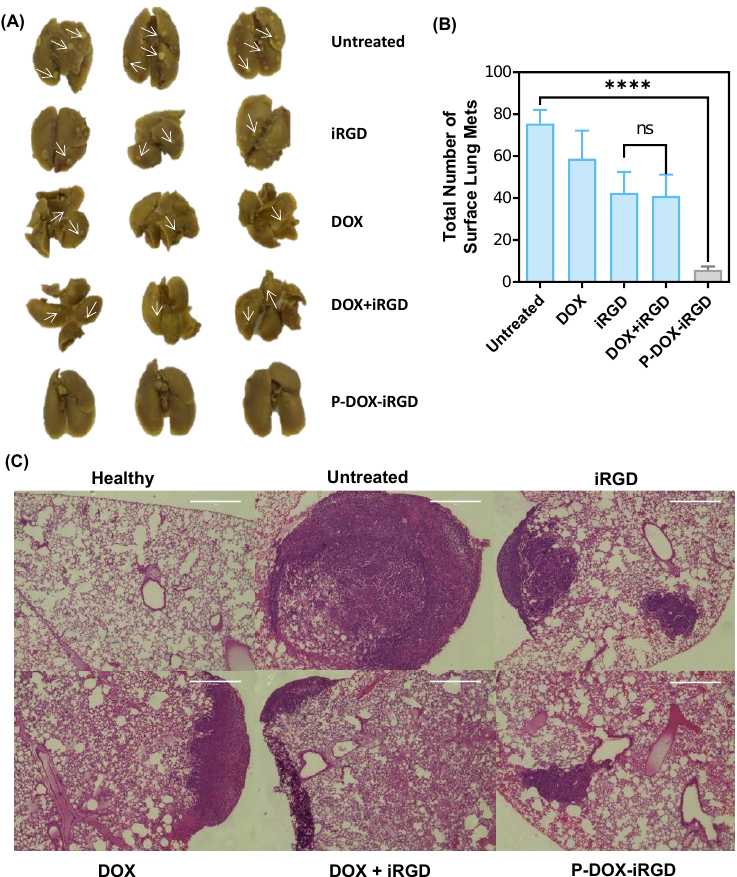
Figure 5. Reduction of breast cancer pulmonary metastasis. ( A ) Representative images of lungs. ( B ) Number of pulmonary metastatic foci. ( C ) H&E-stained lungs metastases from 4T1 tumor-bearing mice. Data are expressed as mean ± SD. **** p < 0.0001 . Scale bar = 100 μm